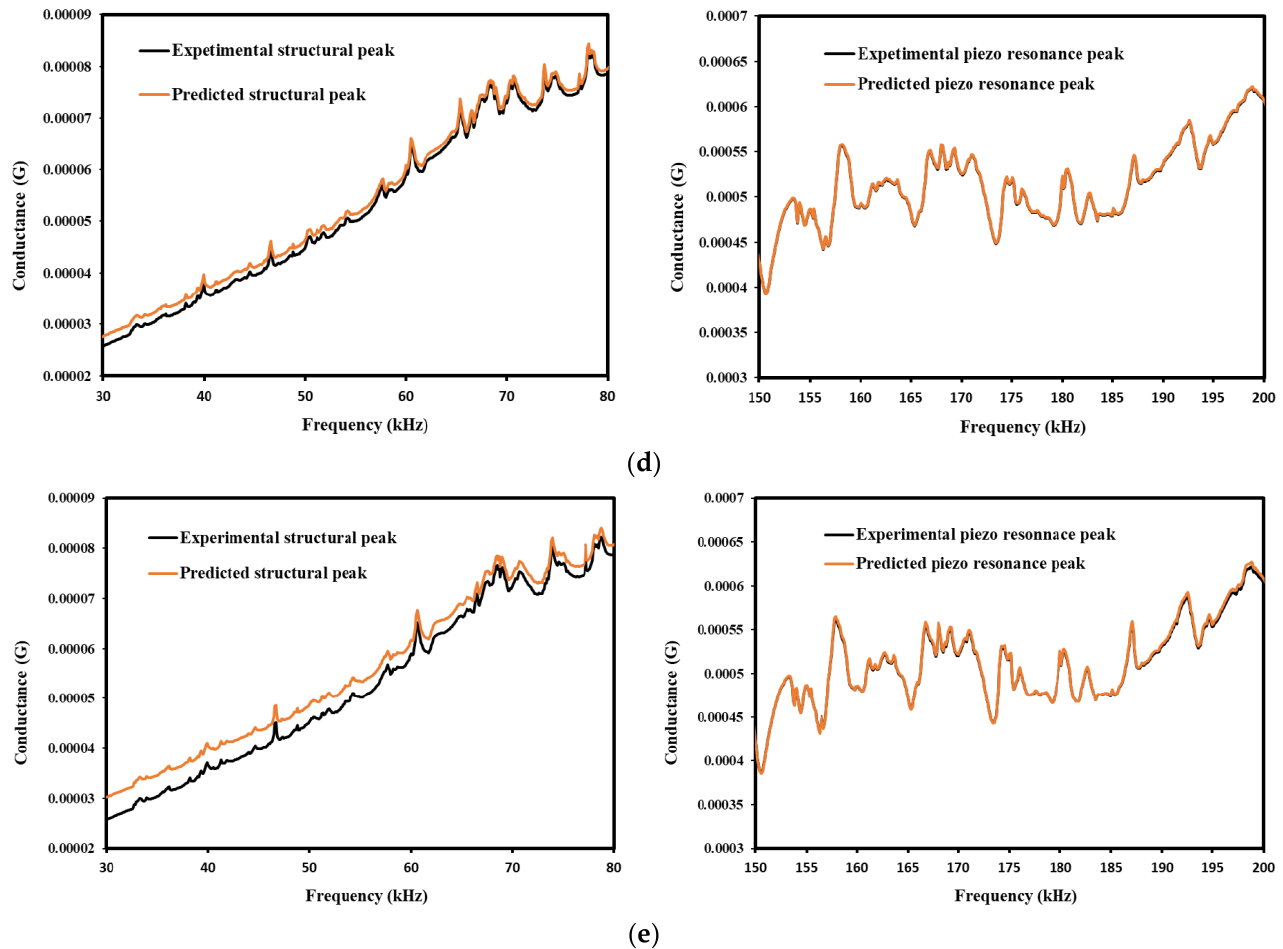
Figure 17. Comparison between experimental and predicted structural and Piezo resonance peak of ( a ) Baseline, ( b ) Strain Displacement @5 mm, ( c ) Strain Displacement @10 mm, ( d ) Strain Displacement @15 mm, ( e ) Strain Displacement @20 mm.